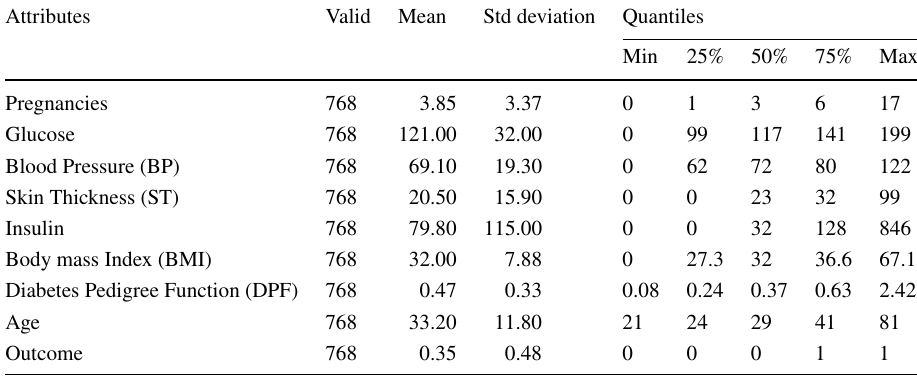
Table 7 Characteristics of PIMA